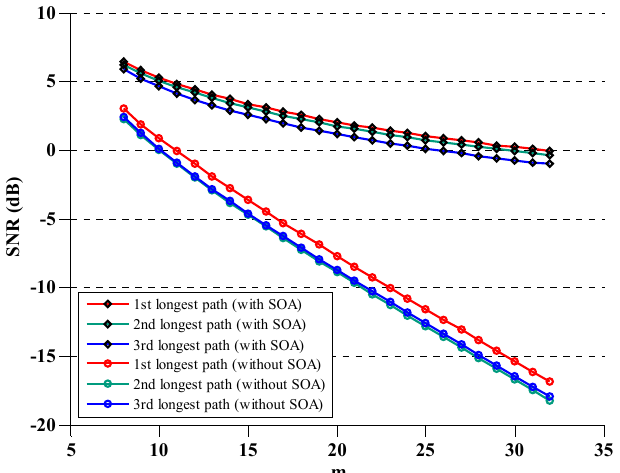
Figure 12. SNR comparison for the 1st, 2nd and 3rd longest paths between SOA-enabled HONoC and conventional HONoC (without SOAs) in accordance with the mesh size.